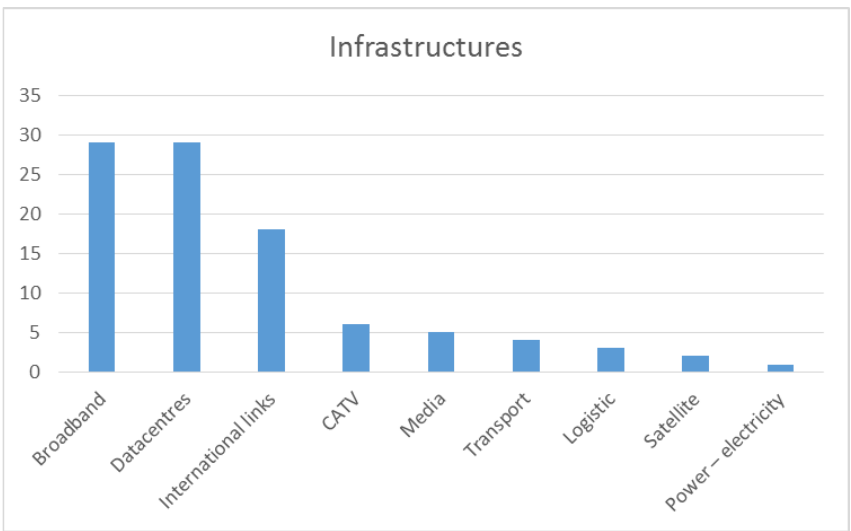
Fig. 10. Infrastructure related topics by number of